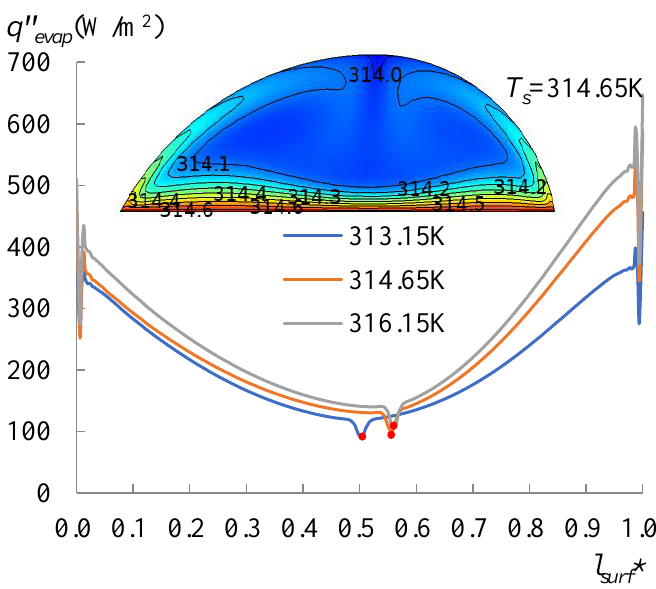
Figure 12. The heat flux due to the evaporation occurred at the LA interface for T s = 313.15 to 316.15 K. The lowest point moved rightwards with the increasing heating temperature.